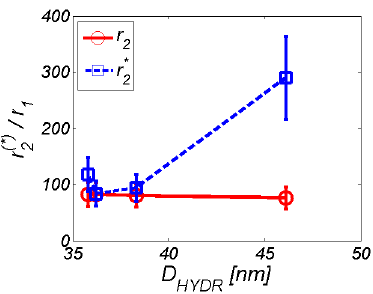
Figure 14. Ratio of transverse and longitudinal relaxivity depending on hydrodynamic diameter.